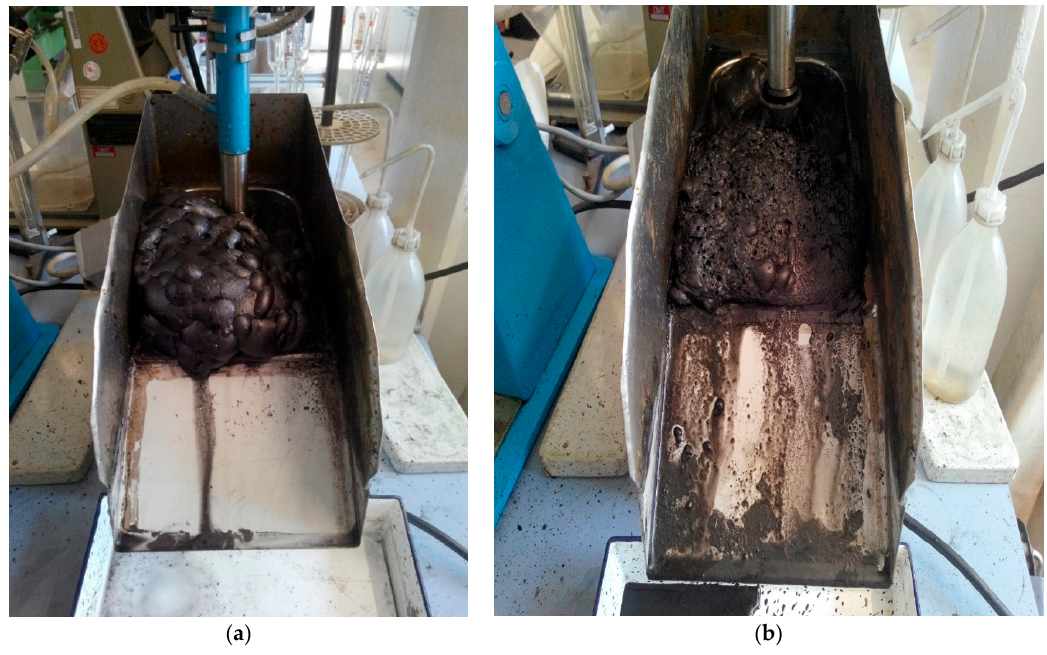
Figure 5. Photos of the coal froths. ( a ) Conventional; ( b ) ultrasonic.